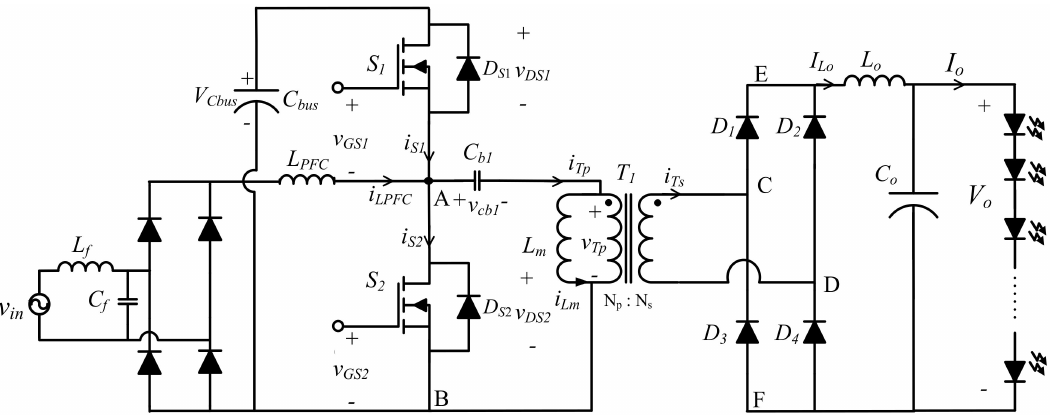
Figure 1. Proposed dimmable light-emitting diode (LED)